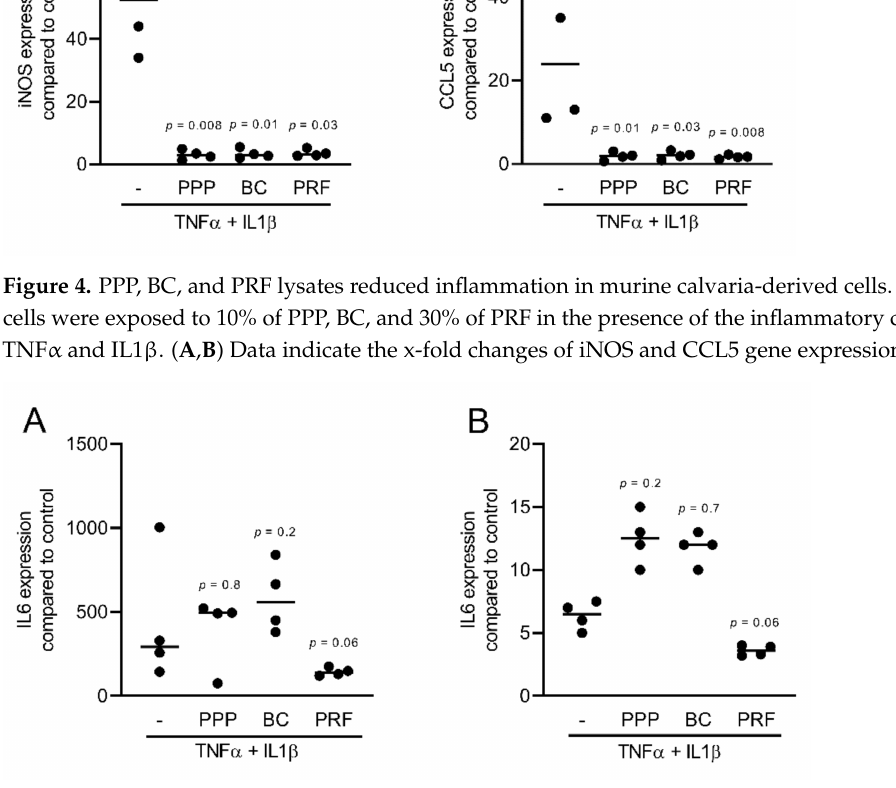
Figure 5. None of the fractions reduced inflammation in gingival fibroblasts and HSC2. Gingival fibroblasts and HSC2 were incubated with 10% of PPP, BC, and 30% of PRF in the presence of TNF α and IL1 β . In gingival fibroblasts, 10% of Alb-gel and RC were also added. ( A , B ) Data indicate the x-fold changes of IL6 gene expression, n =